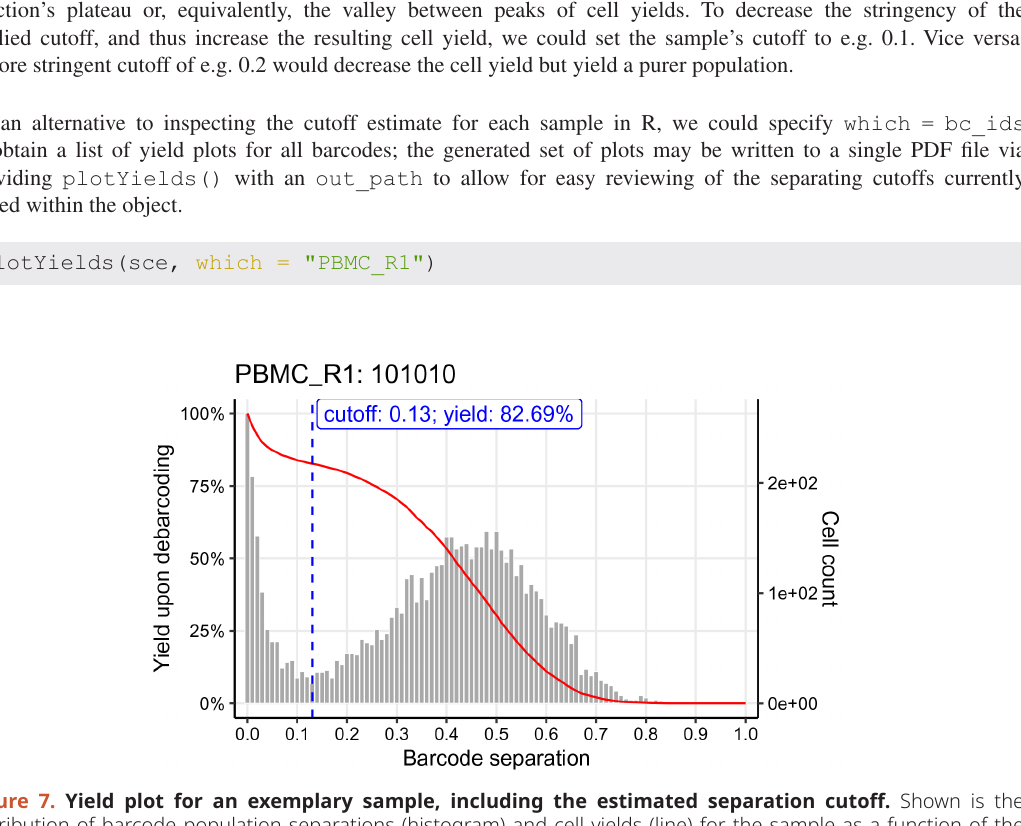
Figure 7. Yield plot for an exemplary sample, including the estimated separation cutoff. Shown is the distribution of barcode population separations (histogram) and cell yields (line) for the sample as a function of the applied sample-specific separation cutoff. Left axis corresponds to cell yield in percent; right axis to the total number of